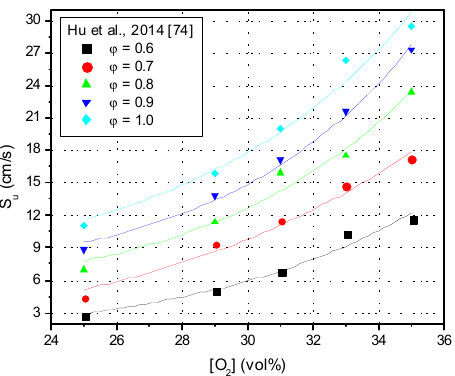
Figure 18. Influence of O 2 concentration on the experimental laminar burning velocities of biogas mixtures.